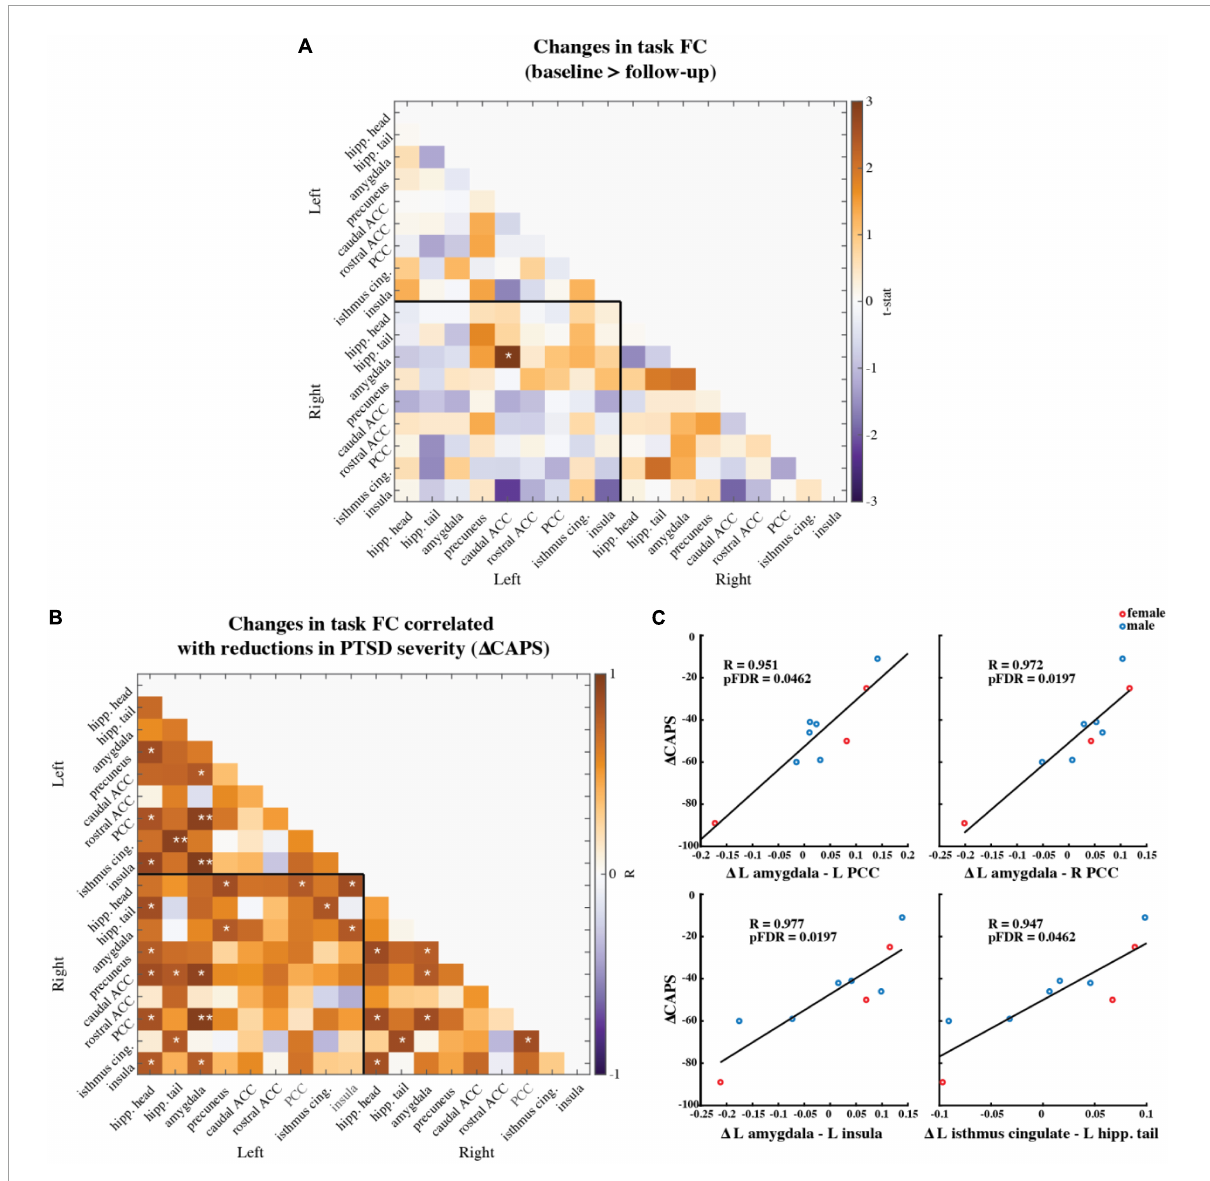
FIGURE5 (A) Paired t-statistics shown for differences in functional connectivity between all brain regions of interest during the task fMRI scan involving neutral and trauma memory audio listening ( N = 9; baseline > follow-up; *two-sided uncorrected p < 0.05; **pFDR < 0.05, corrected). (B) Pearson correlation values between changes in ROI functional connectivity and reduction in CAPS scores. Changes were calculated as follow-up values minus baseline values. ( N = 9; *uncorrected p < 0.05; **pFDR < 0.05) Age and mean FD difference between baseline and follow-up were included as covariates of non-interest. (C) Scatter plots of the three correlations that remained significant after corrections for multiple comparisons (i.e., pFDR < 0.05). Red marker = female. Blue marker =